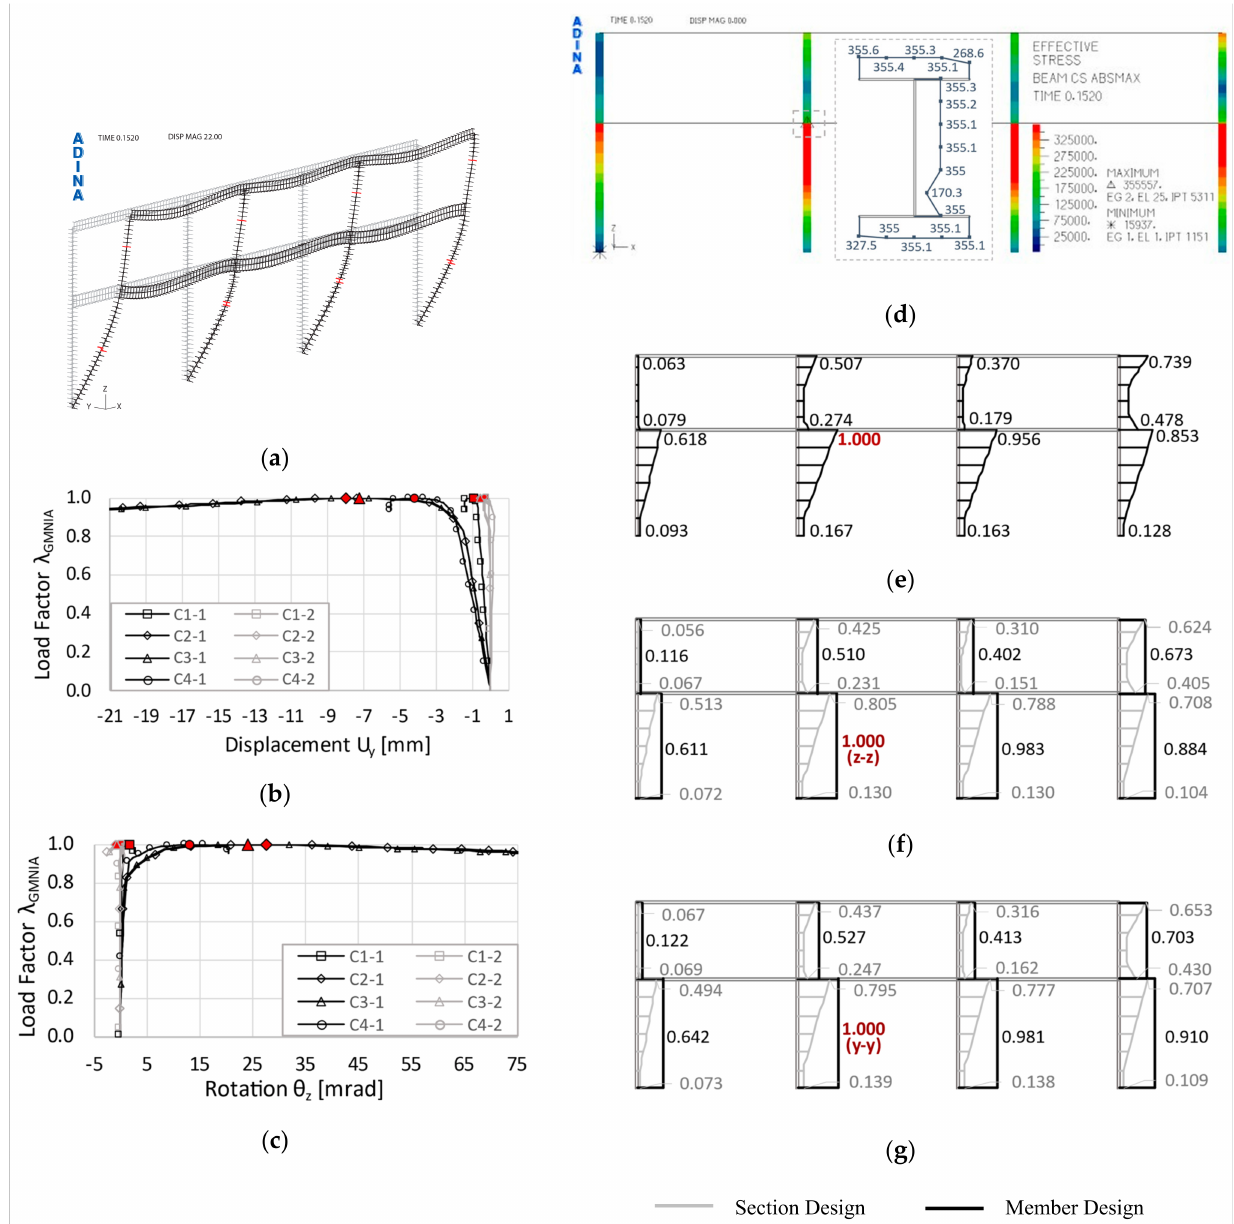
Figure 9. Collapse mechanism and utilization level of LS frame—( a ) deformed shape (GMNIA); ( b , c ) equilibrium paths (GMNIA); ( d ) stress distribution (GMNIA); ( e ) utilization level (GNIA-SD); ( f ) utilization level (GNA-SMD); ( g ) utilization level